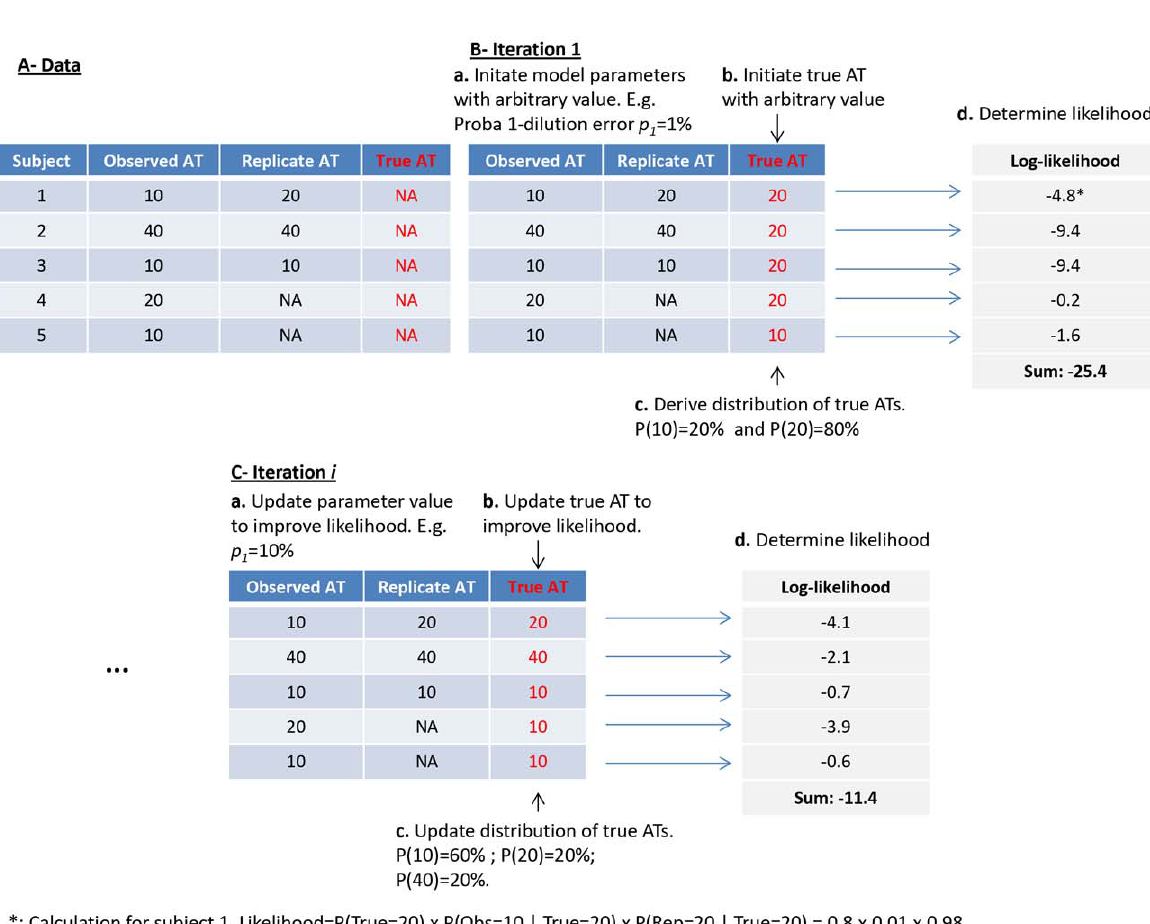
Figure S3 Testing the absence of cross-reactivity be- tween subtypes. For each year and each subtype, individuals were partitioned between those with no increase in titers (coded 0), those with a 1-dilution increase (coded 1) and those with a 2 dilution or more increase (coded 2). The population was then partitioned in 27 groups according to outcome for triplet H1N1- H3N2-B. For example triplet 1-0-0 consists of individuals with a 1- dilution increase for H1N1 but no increase for H3N2 and B; 1-2-0 are individuals with a 1-dilution increase for H1N1, 2-dilution increase for H3 but no increase for B etc. Red points show the mean posterior distribution for triplet H1N1-H3N2-B, corrected for measurement errors. The boxplots in the figure show the distribution that would be obtained if there was no cross-reactivity between subtypes. Figure S4 Age-specific distribution of paired serology, corrected for measurement errors as a function of season (2008, Spring 2009, Autumn 2009) and subtype (H1N1, H3N2 and B) (in Autumn 2009, subtyping was only conducted for H1N1pdm09). In each panel, individuals are sorted by baseline AT levels on the y-axis. For a given baseline, the grey bar indicates the expected proportion of individuals with